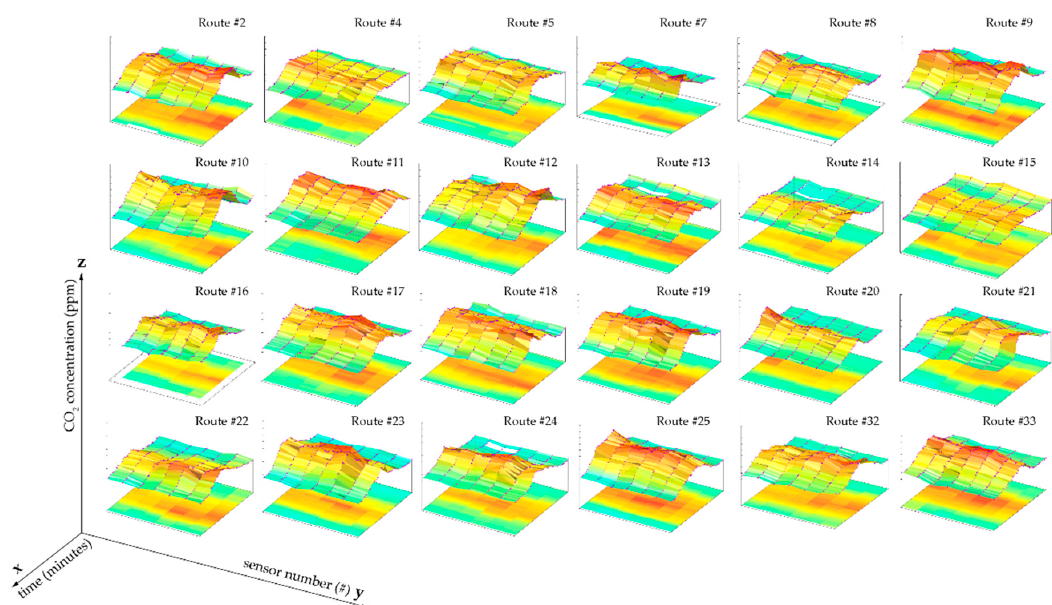
Figure 6. Distribution of ∆ CO 2 in the Tram ( z -axis) as a function of time ( x -axis) and ∆ CO 2 measures ( y -axis) on routes #2, #4–#25, and #32–#33, where there is homogeneity in the CO 2 measurement along the tram and a strong relationship with occupancy.